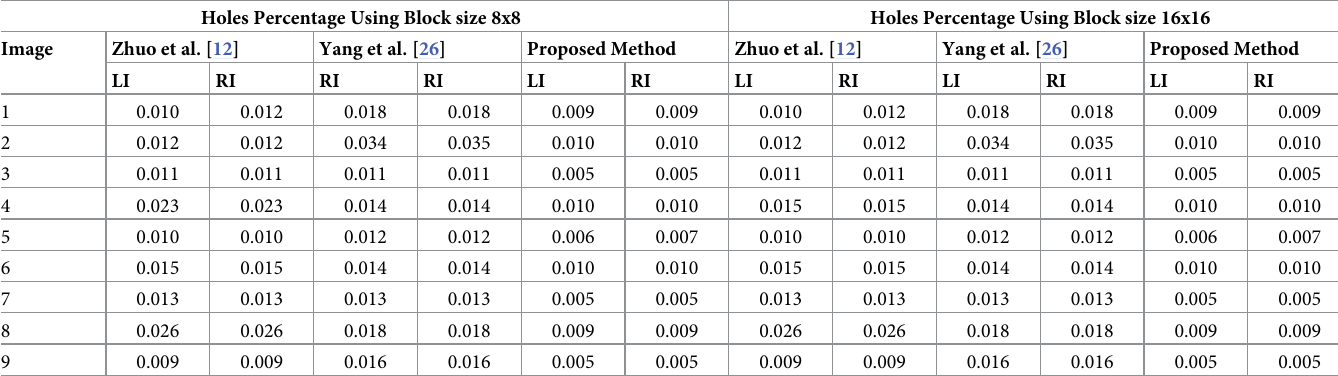
Table 5. Holes percentage using block size 8x8 and block size 16x16 tested dataset [38]. Holes Percentage Using Block size 8x8